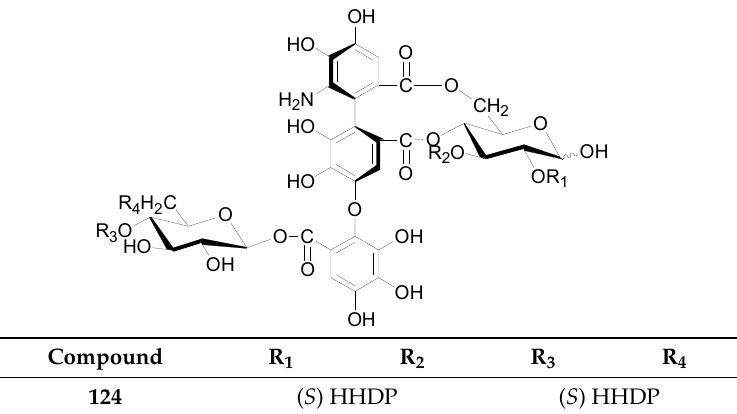
Table 6. Structures of compounds 124 .